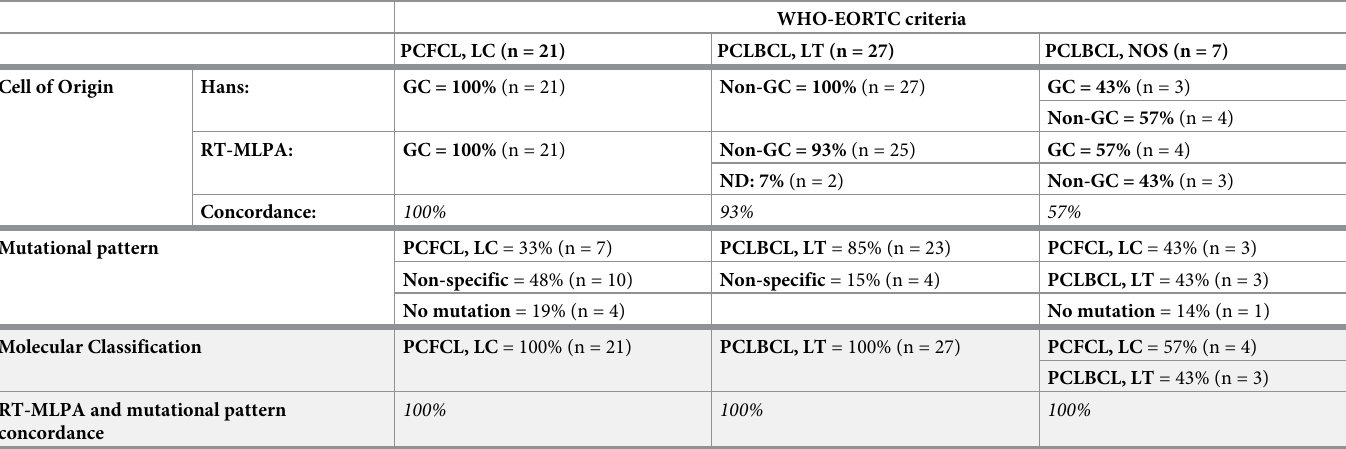
Table 2. Determination of cell of origin status (Germinal centre GC or Non-GC) according to the Hans’ algorithm, RT-MLPA assay and mutational analysis of 55 primary cutaneous large B-cell lymphomas.